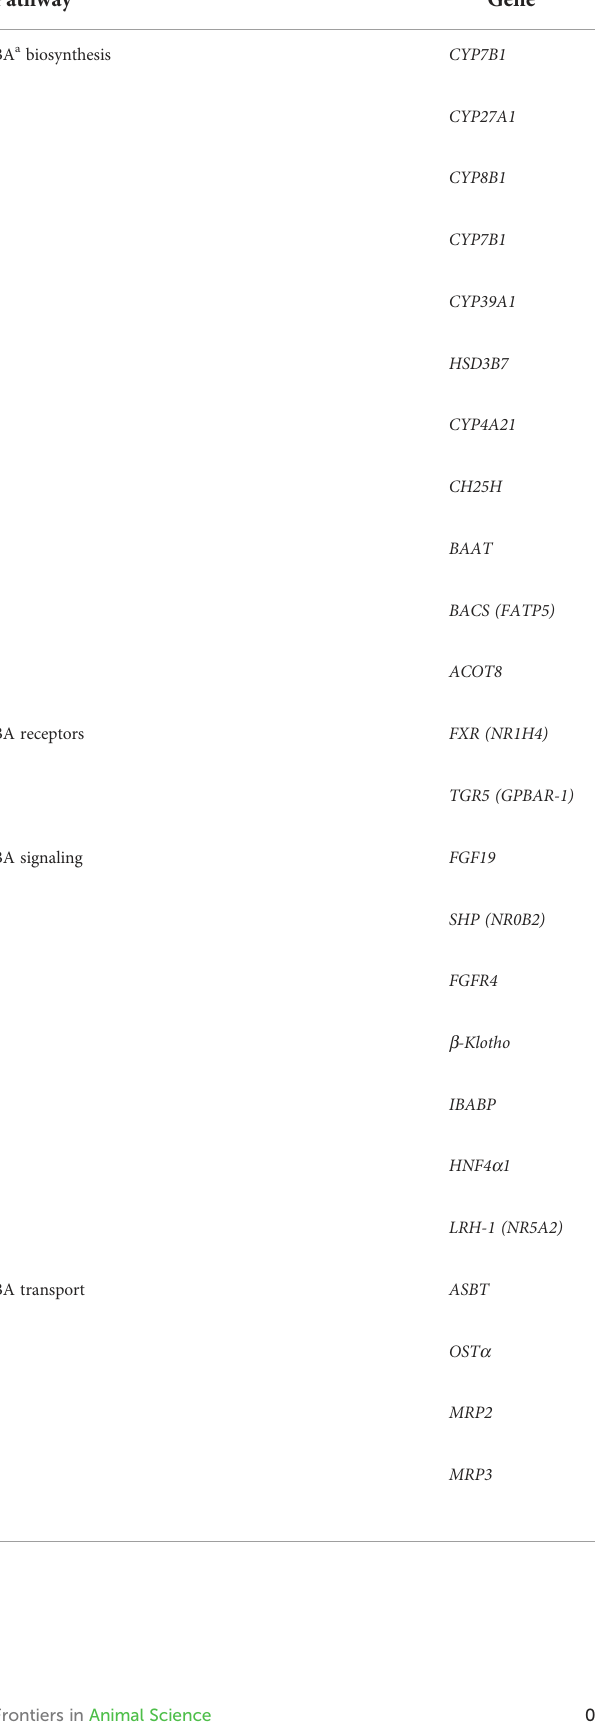
TABLE 1 Pr imers for genes related to BA biosynthesis, receptors, signaling and transport.